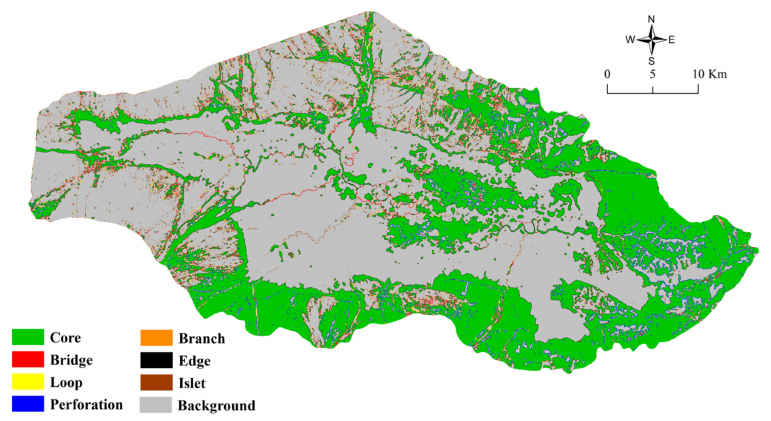
Figure 6. Pattern classes of the study area based on